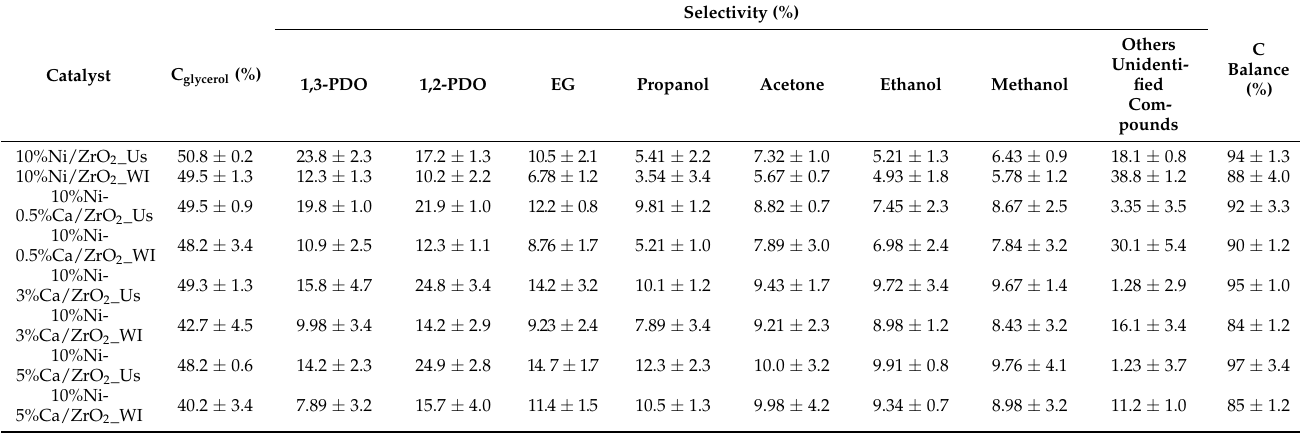
Table 2. Catalytic performance of various catalysts for glycerol APR.